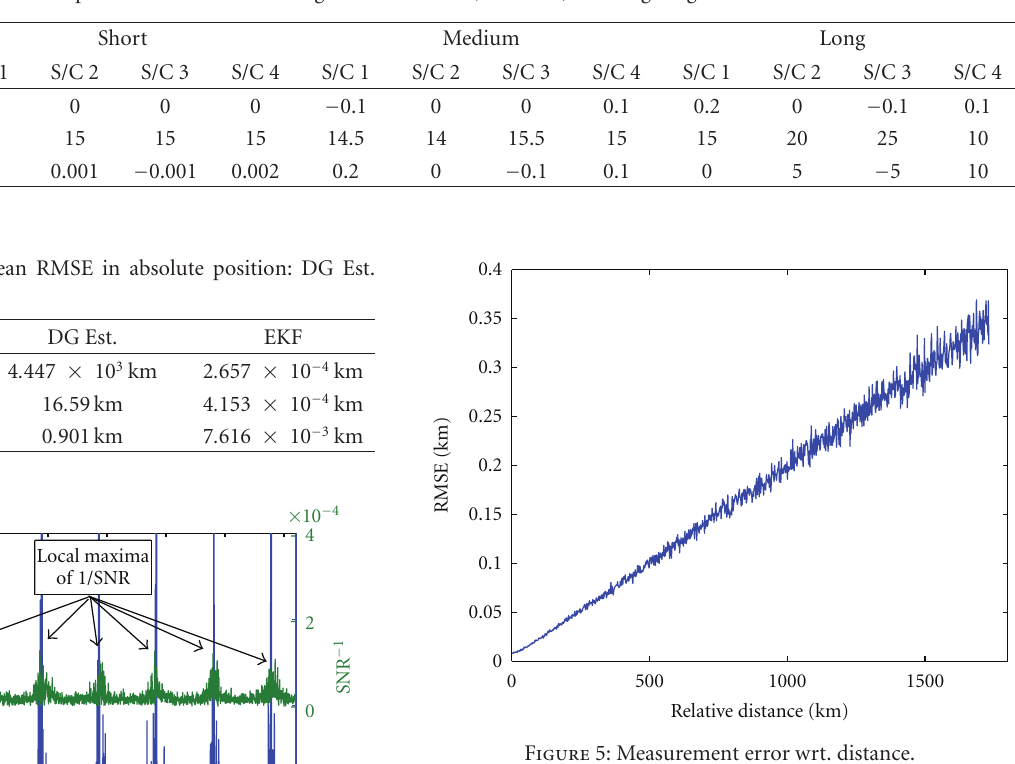
Table 1: Spacecraft formation’s configuration for short, medium, and long range formation.